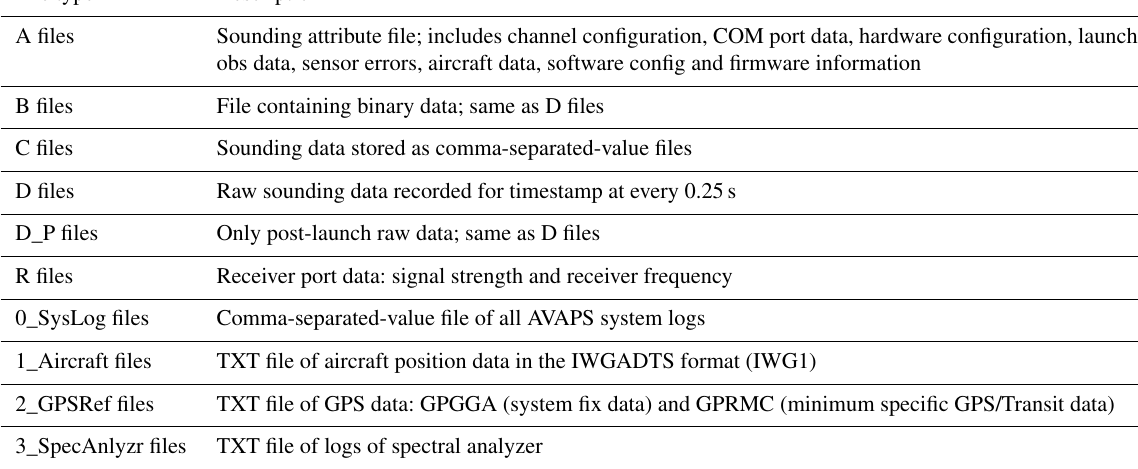
Table 4. File types included in Level 0, which are all files in the raw data collected by the dropsondes, and a brief description of what they